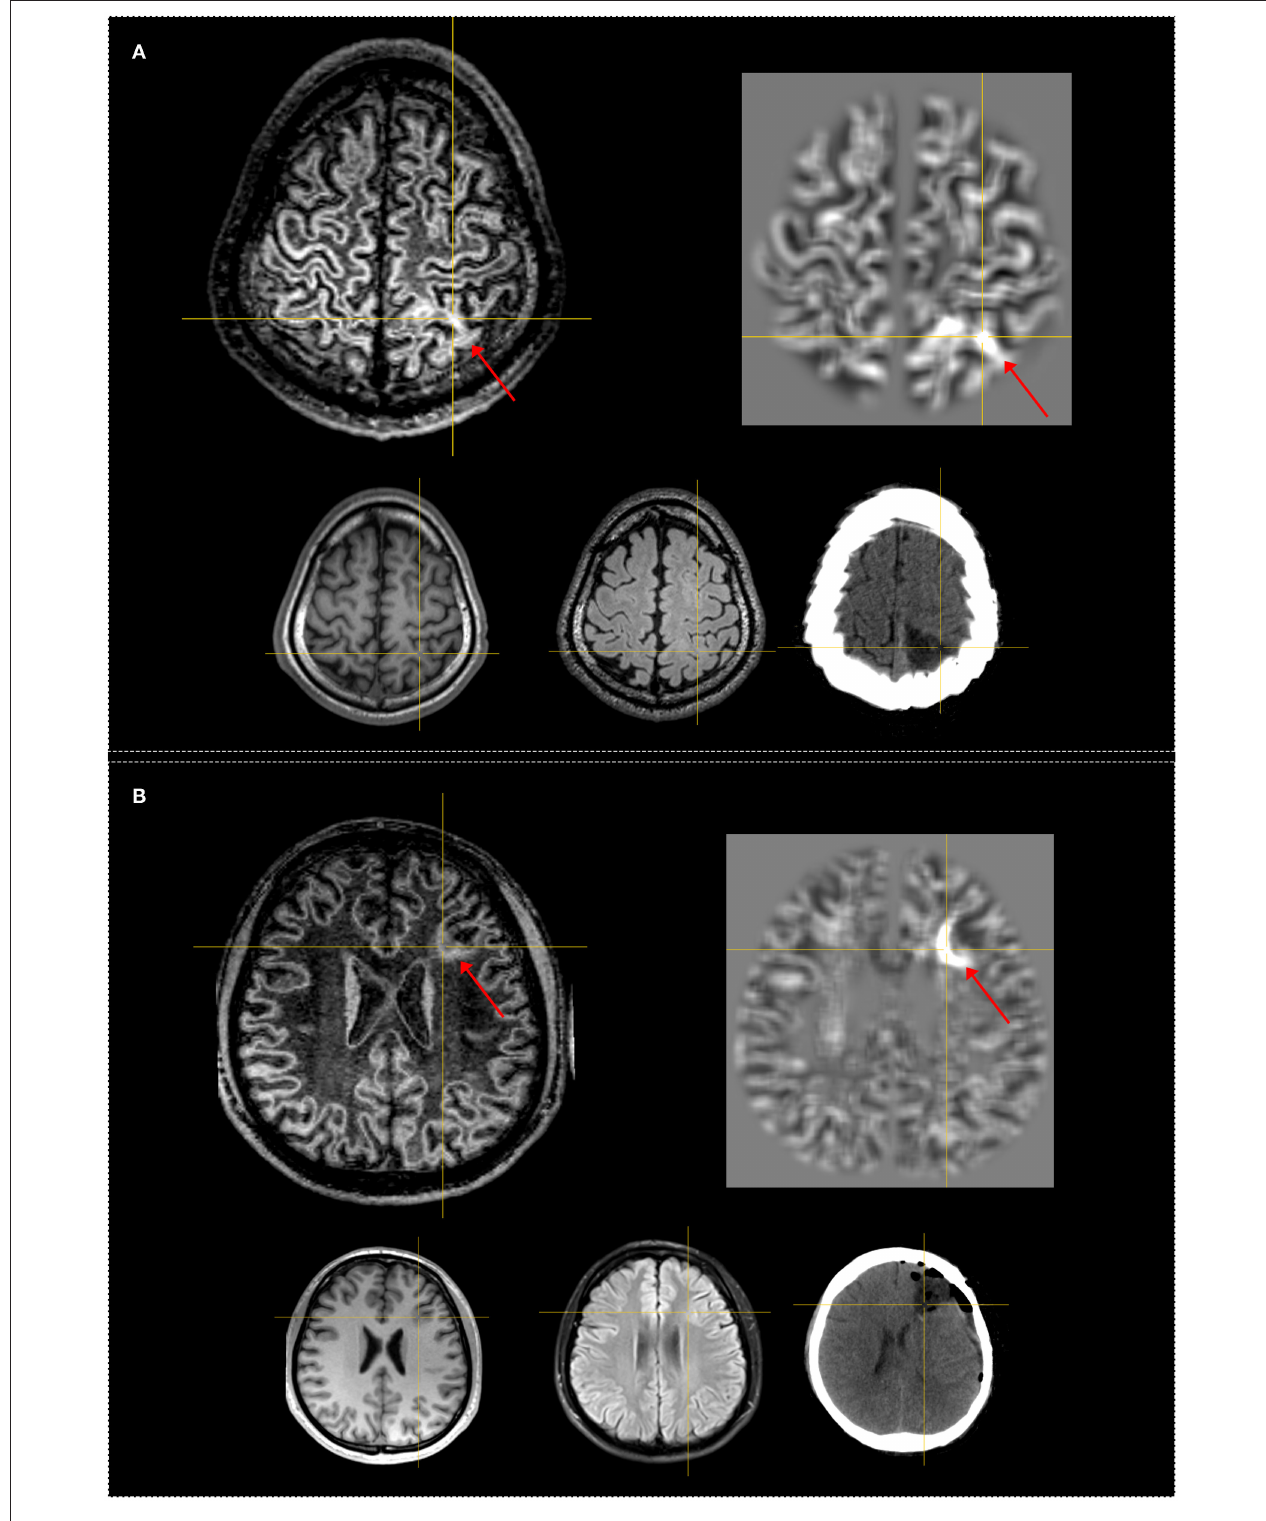
FIGURE 2 | Examples of patients having FLAWS–MAP gyral + region concordant with the surgical resection cavity. Both patients remained seizure-free at 12 months. The crosshairs indicate the same coordinate between different images. The red arrows indicate the FLAWS + or MAP + region. Upper, left: registered FLAWS